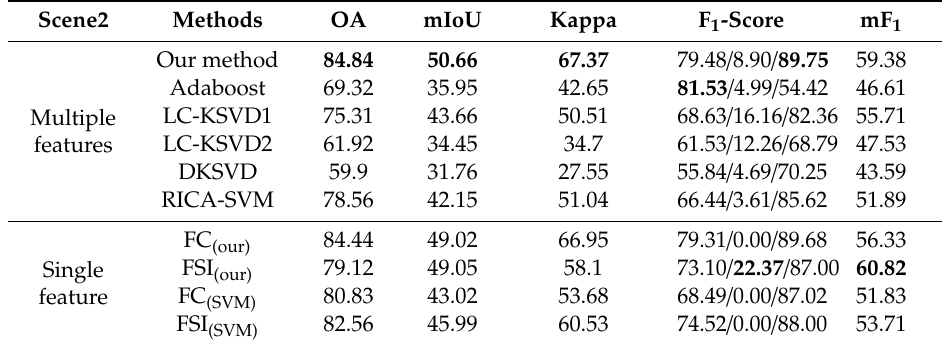
Table 3. Classification results of Scene2 (%). F 1 -score corresponds to the accuracy in terms of buildings, cars and trees. Note that the highest accuracy values are highlighted in bold.